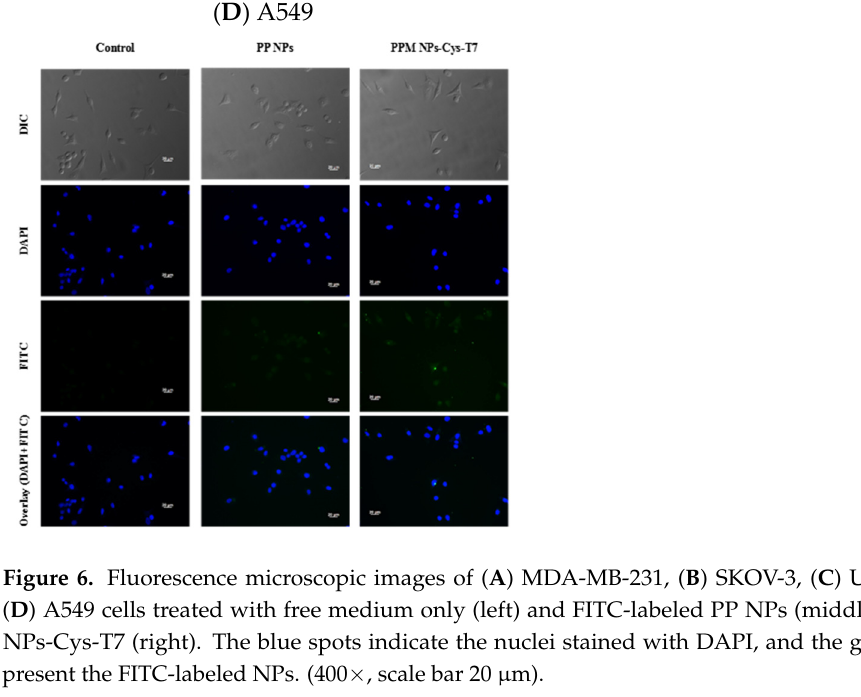
Figure 6. Fluorescence microscopic images of ( A ) MDA-MB-231, ( B ) SKOV-3, ( C ) U87-MG and ( D ) A549 cells treated with free medium only (left) and FITC-labeled PP NPs (middle) and PPM NPs- Cys-T7 (right). The blue spots indicate the nuclei stained with DAPI, and the green signals present the FITC-labeled NPs. (400×, scale bar 20 µm).